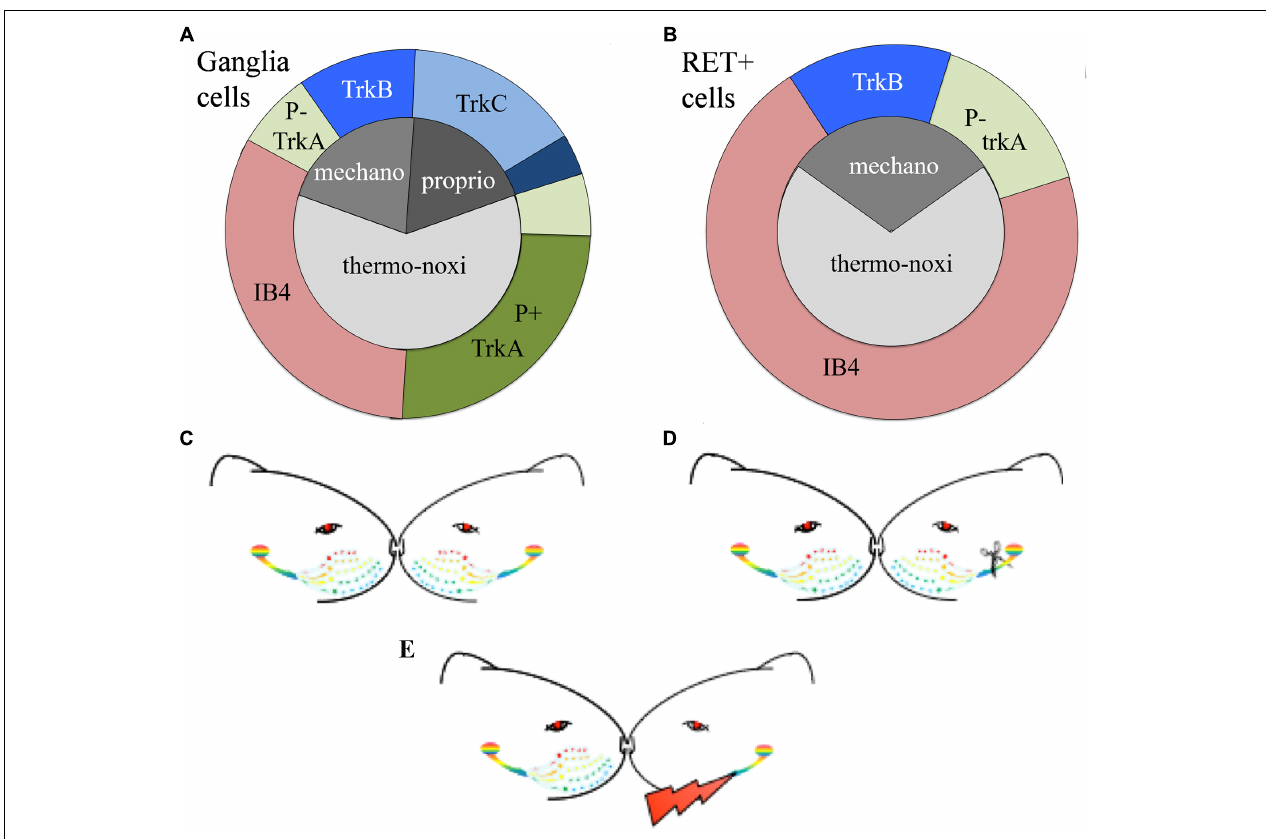
FIGURE 1 | (A,B) Schematic representation of the distributions of TG neurons according to the expression of their receptors. (A) Approximately 65% of trigeminal neurons are thermo-nociceptors; half of them express TrkA and the rest are IB4 positive. Mechanoreceptors/proprioceptors express either TrkB or TrkC and some of them both; non-specific mechanoreceptors/proprioceptors are represented by deep blue. (B) RET-positive ganglia neurons co-express IB4, trkA, or trkB or none of them. RET-positive neurons do not cover all trkA- and trkB-positive cells. Non-frequent or controversial co-expressions like TrkB-TrkC are not depicted in this figure. (C–E) Schematic representation of the experimental paradigm. (C) Control “C” animals with bilateral intact trigeminal nerves and ganglia; (D) axotomized “A” animals with unilateral-left side axotomized trigeminal neurons and (E) stimulated “S” animals with electrode implant and electrical stimulation of the axotomized